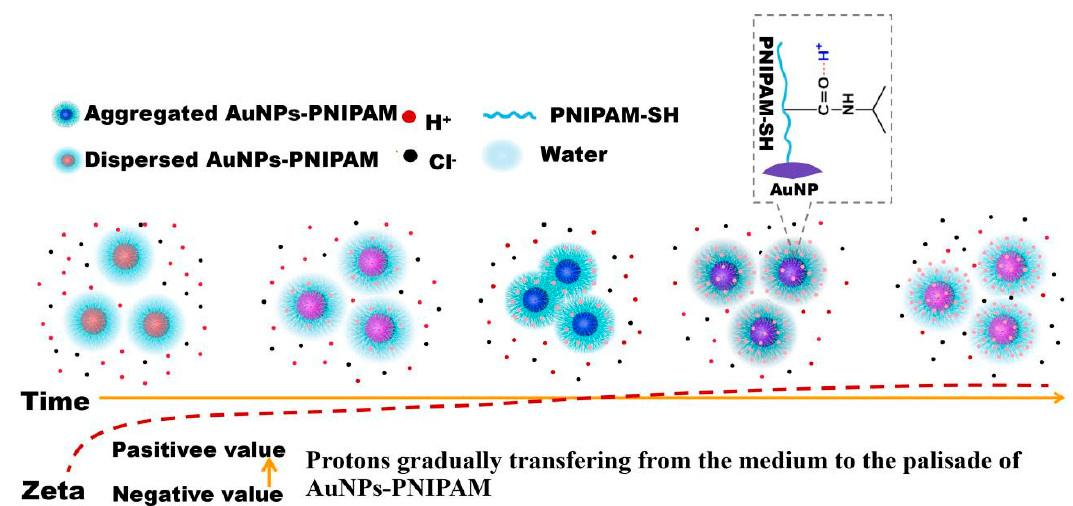
Figure 8. A possible mechanism on the variation of AuNPs-PNIPAM Zeta potential with time in HCl medium. In this process, protons slowly enter into PNIPAM palisades due to protons binding on amide O of PNIPAM, which results in the aggregation of AuNPs-PNIPAM caused by a decrease in Zeta potential. Further increase of protons in PNIPAM palisades makes negatively charged AuNPs-PNIPAM positive, forming the hydrated PNIPAM shell to inhibit the aggregation.